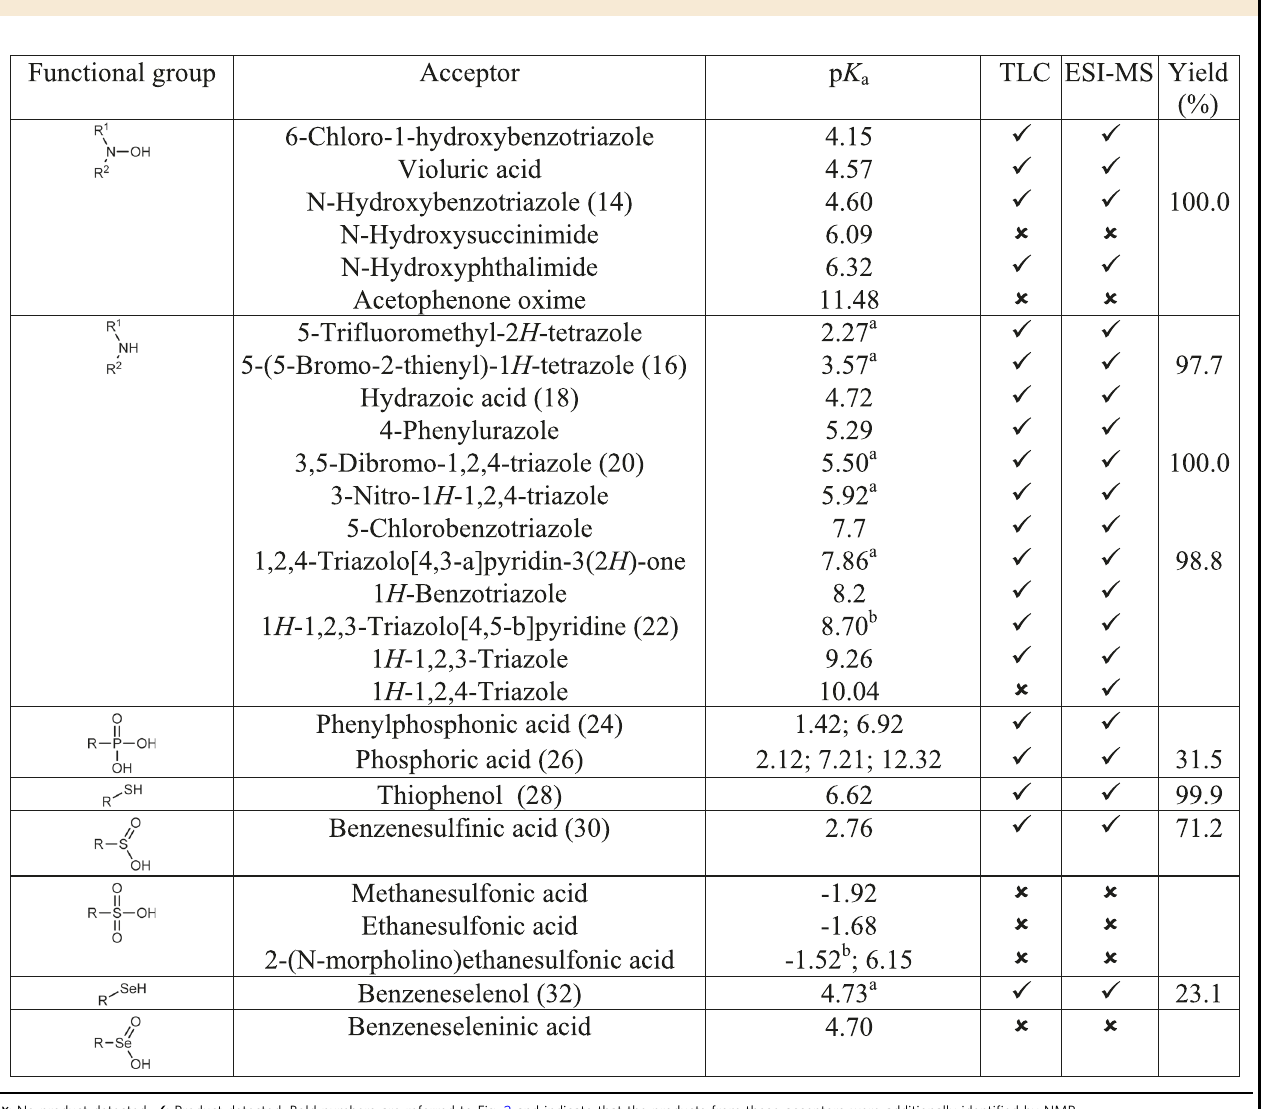
Table 2 Screening of acceptors for rBxTW1-E495A: N-, P-, S-, and Se-containing target functional groups.